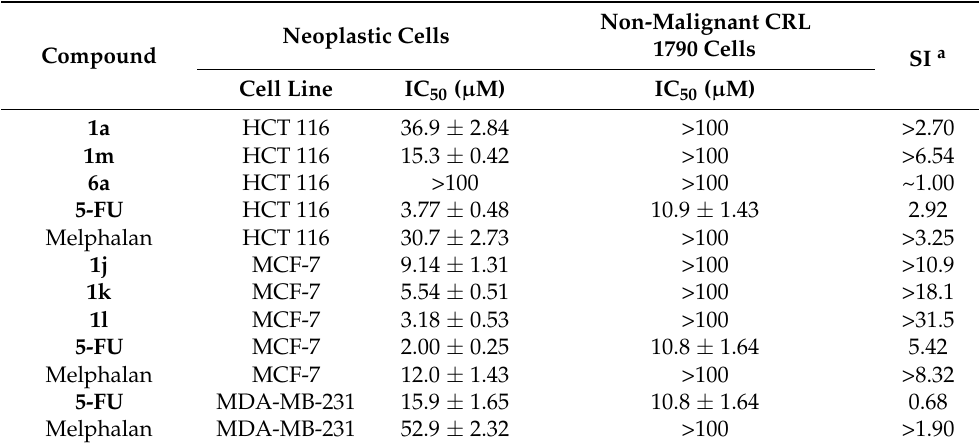
Table 2. Quantitative evaluation of the cytotoxicity of selected